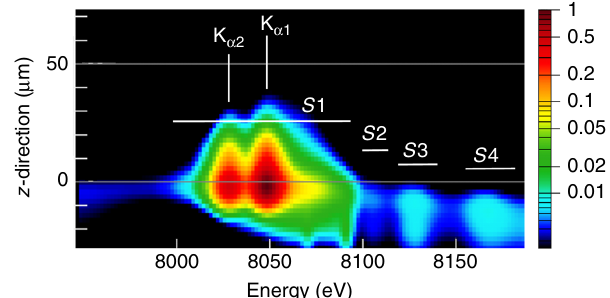
Fig. 3 Synthetic z -resolved spectra. The spectral intensities are mapped into colors on logarithmic